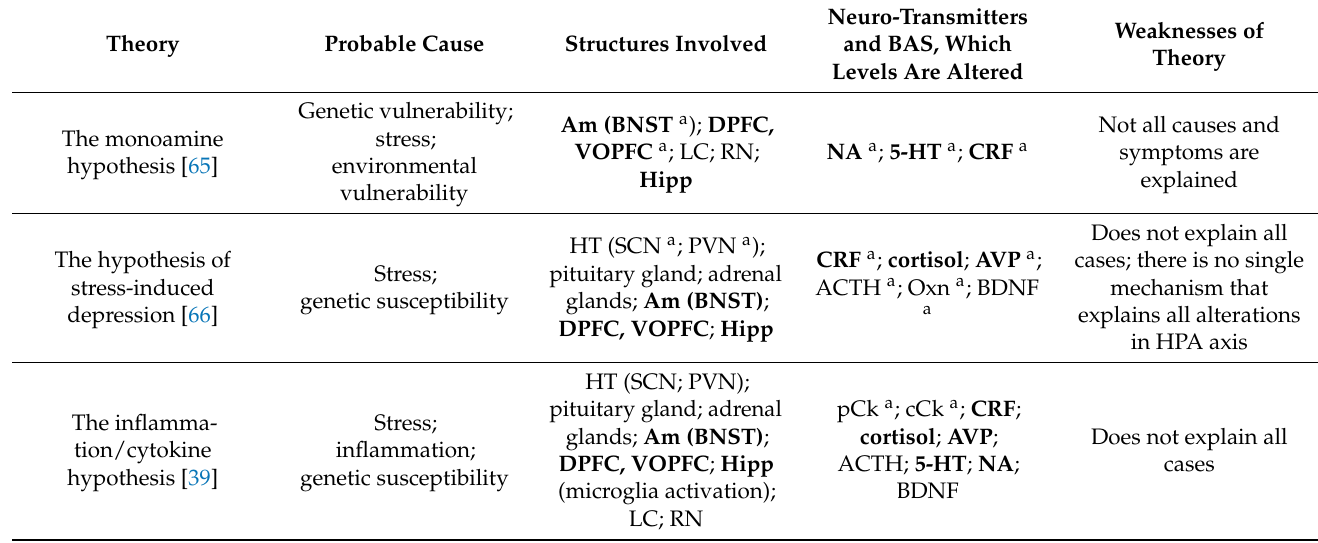
Table 1. The major theories of